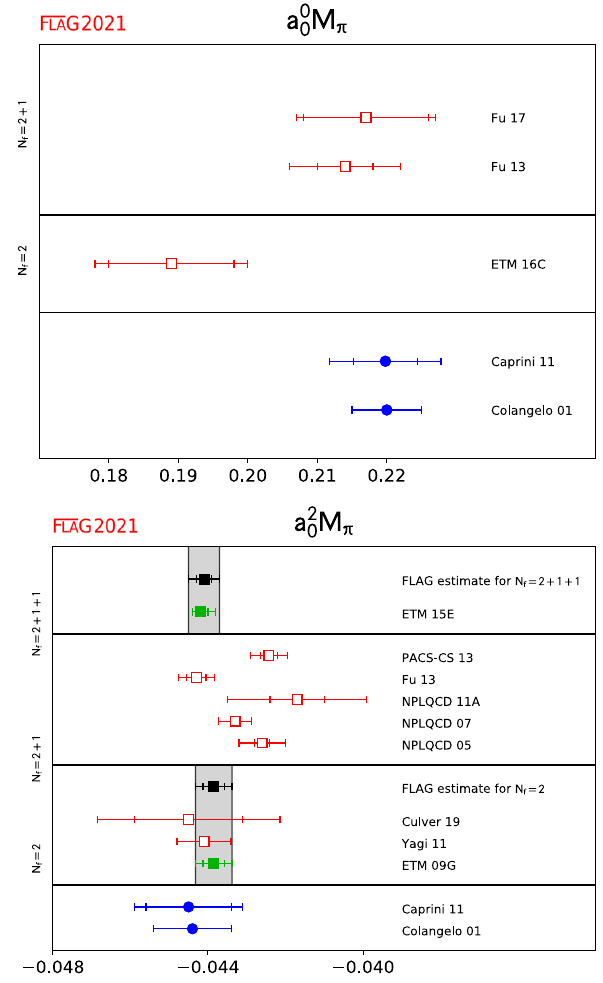
Fig. 18 Summary of the ππ scattering lengths a 0